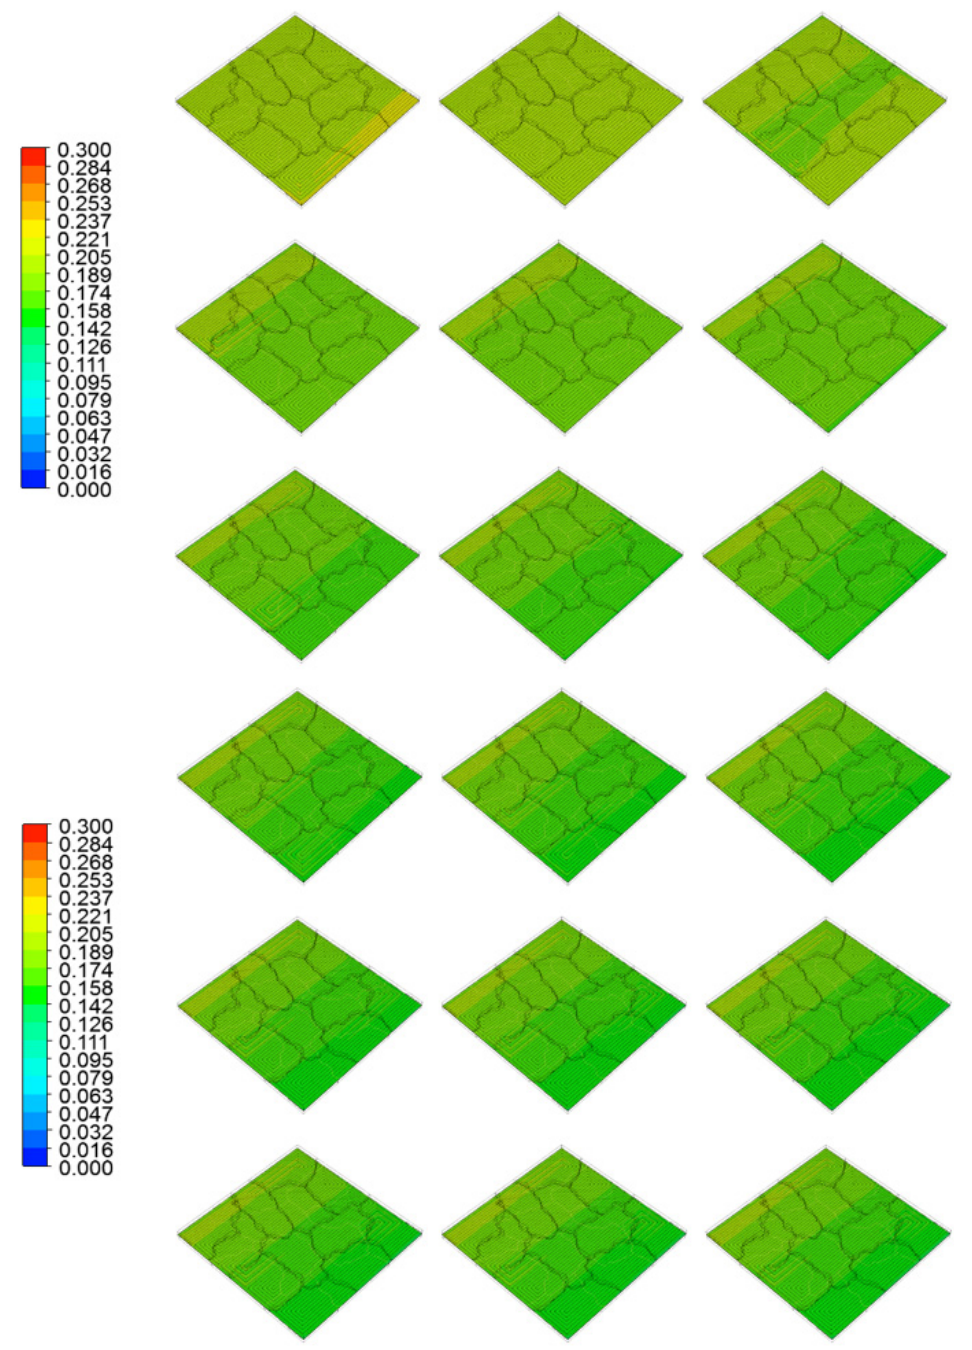
Figure 10. Anode catalyst layer hydrogen mass fraction history every 1 s, from 28 ( top left ) to 45 s ( bottom right ). Anode inlet left corner, anode outlet right corner.